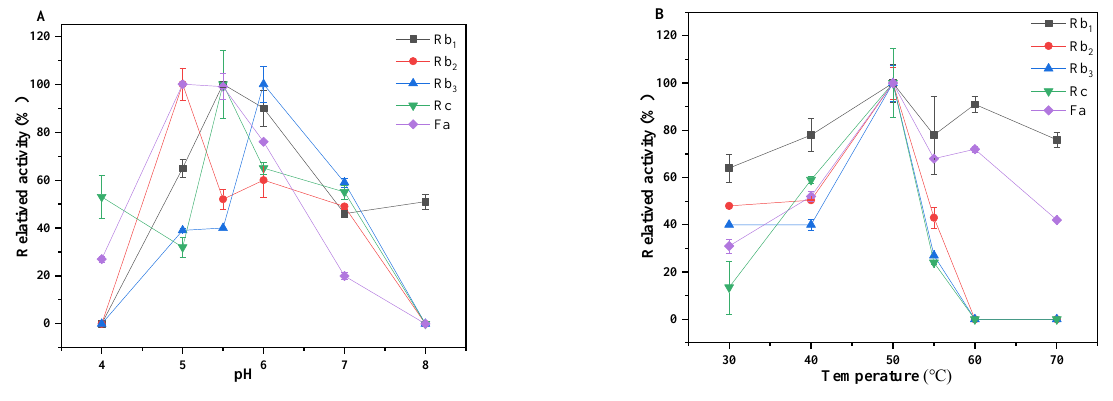
Figure 6. Effect on reactions: pH ( A ) and temperature ( B ) on the biotransformation of ginsenosides by crude enzymes.